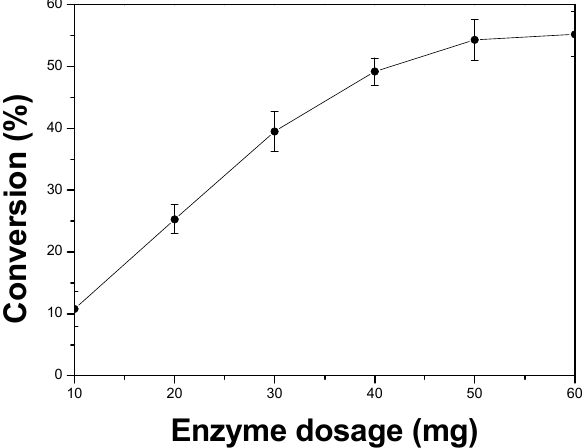
Figure 4. Effects of enzyme dosage on the enzyme-catalyzed esterification of ibuprofen. The reactions were carried out in n -heptane (60 mL), ibuprofen (0.02 M), 1-octanol (0.02 M) and APE 1547 (pH 7.5) with different enzyme dosage. The mixture was incubated in the microwave oven (480 W, 50 °C, 150 rpm) for 5.0 h.